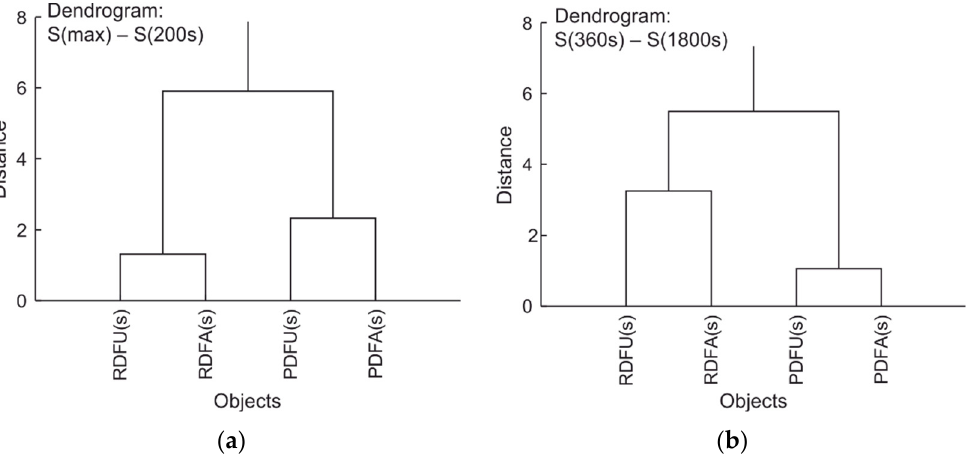
Figure 29. Dendrograms of wavelength shifts: ( a ) data from Table 5; ( b ) data from Table 6.